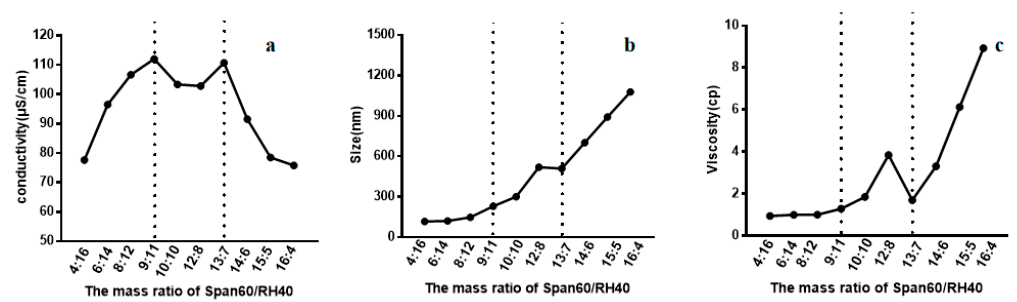
Figure 2. ( a ) Conductivity, ( b ) size, ( c ) and viscosity of the Span60-RH40 system in different mass ratios.